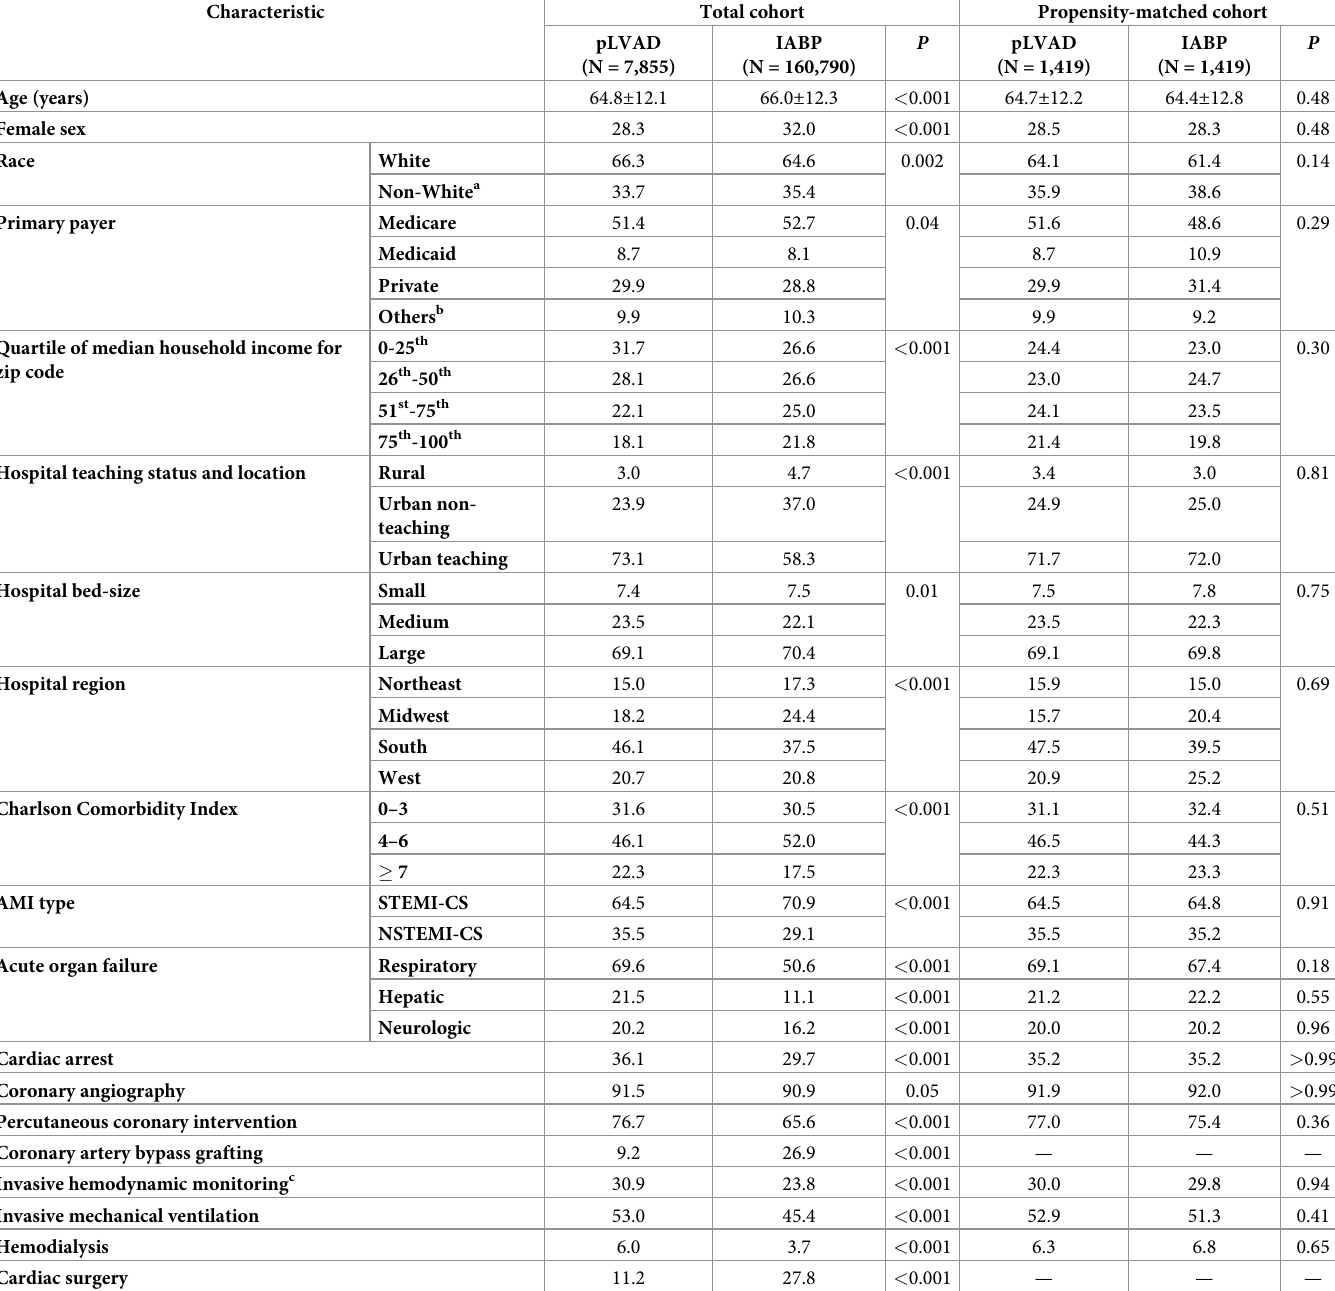
Table 1. Baseline characteristics of AMI-CS admissions receiving pLVAD and